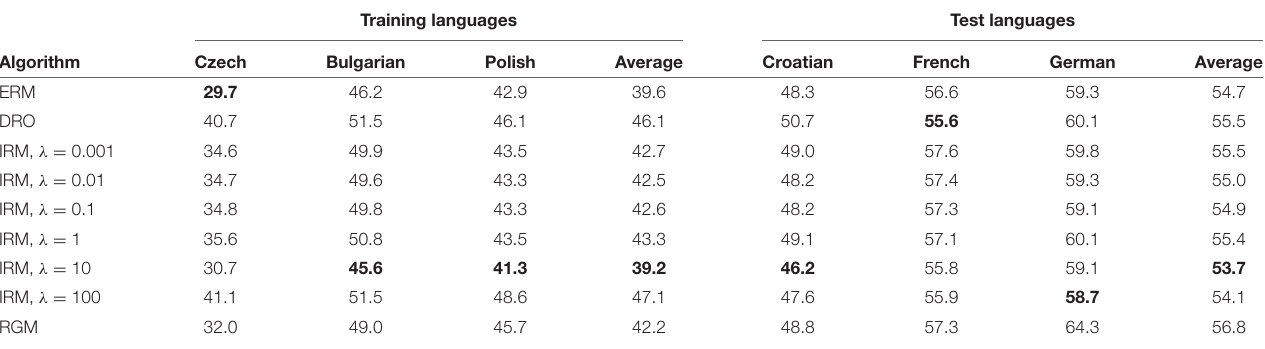
Training languages